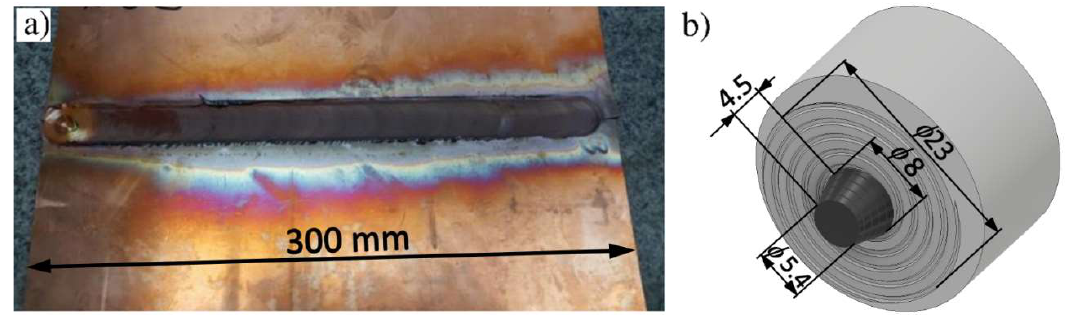
Figure 2. The FSW joint made at ω = 580 rpm, V = 60 mm/min ( a ) and geometry of the tool used for welding ( b ) (dimensions in mm).